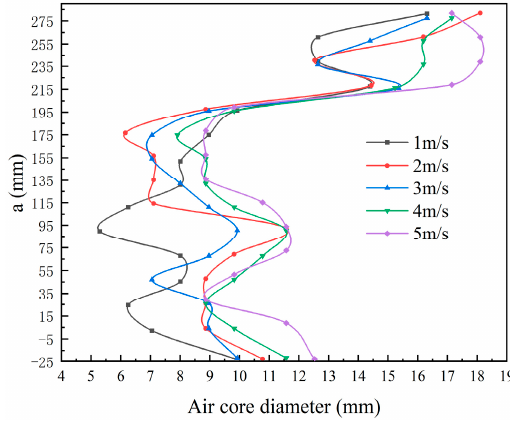
Figure 13. Axial distribution of air column diameter.